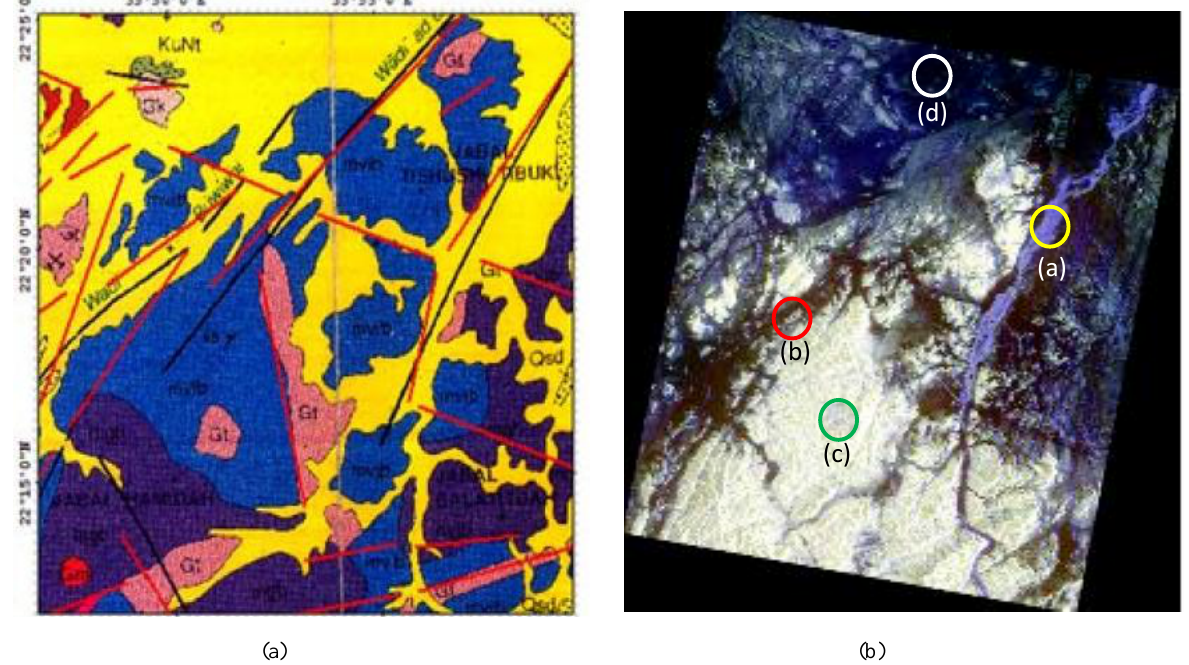
Figure 4. (a) Geological map of the study area, (b) Radarsat-2 PolSAR image in Pauli